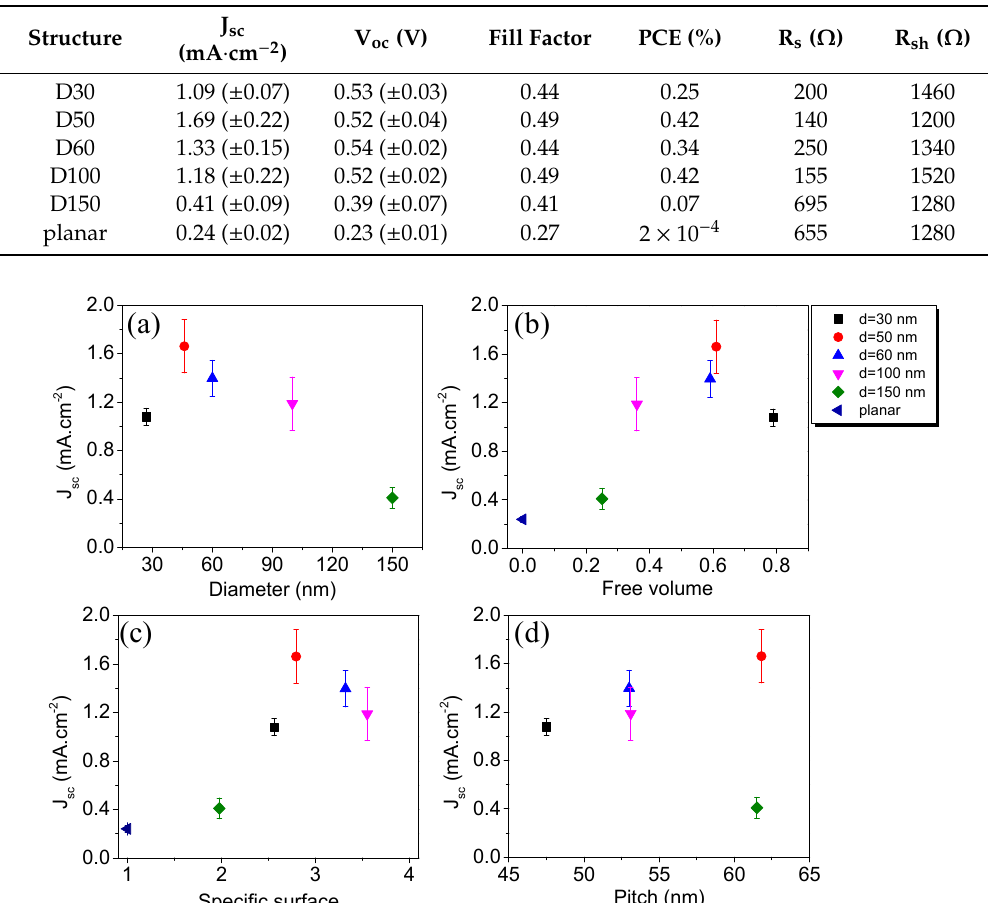
Figure 5. Short circuit current density variation of Si / GaN NW / P3HT:PC 71 BM ordered heterostructures as a function of GaN NW morphological parameters: ( a ) average nanowire diameter; ( b ) free volume of active layer; ( c ) specific surface; ( d ) pitch. Color online.